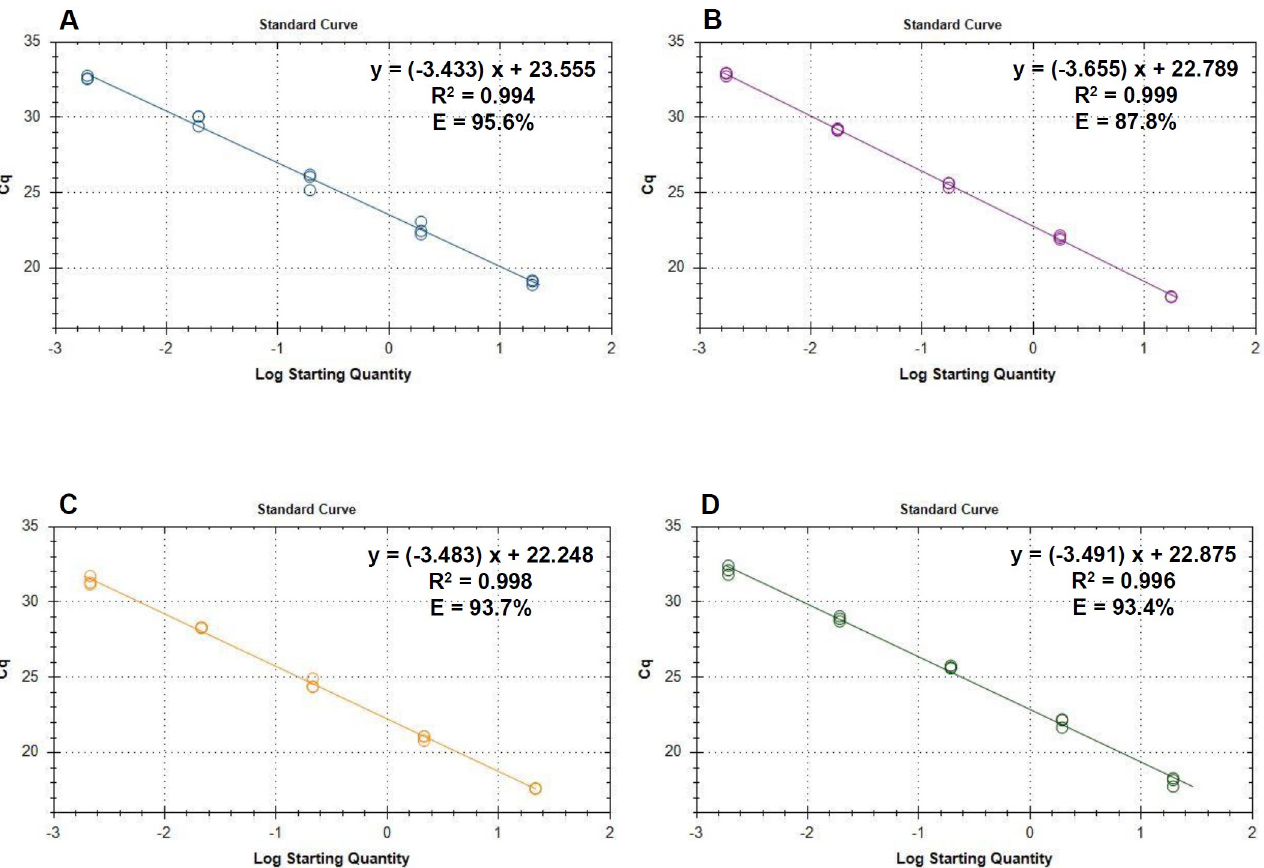
Fig 4. Standard curves for quantification of Diaporthe spp . using the quadruplex qPCR assay. (A) Graph and data of the standard curve for D . longicolla . The highest starting amount was 19.4 ng. The fluorescence threshold was set at 10 RFU. (B) Graph and data of the standard curve for D . caulivora . The highest starting amount was 17.4 ng. The fluorescence threshold was set at 35 RFU. (C) Standard curve for D . eres . The highest starting amount was 21.4 ng. The fluorescence threshold was set at 84 RFU. (D) Standard curve for D . novem . The highest stating amount was 19.4 ng. The fluorescence threshold was set at 42 RFU.